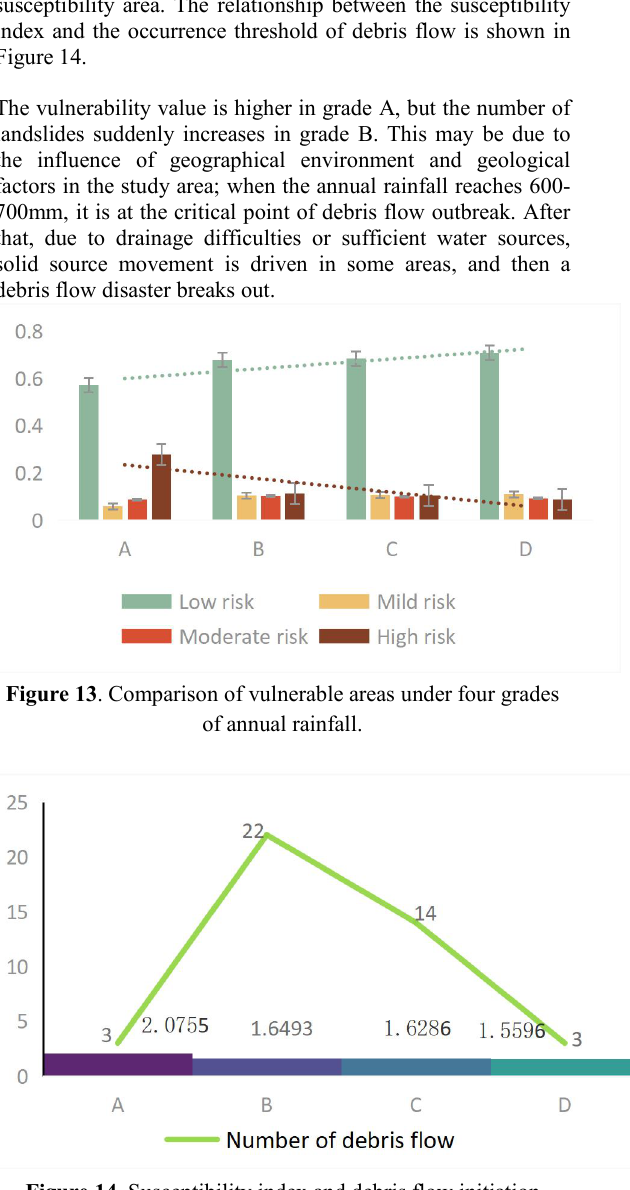
Figure 14 . Susceptibility index and debris flow